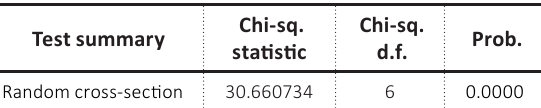
Table 5. Correlated random effects – Hausman test